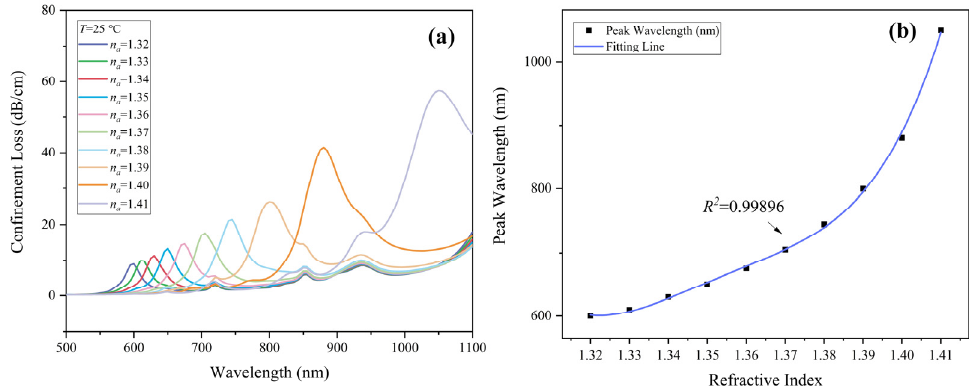
Figure 4. ( a ) CL spectrum of y- polarization core mode with various n a from 1.32–1.41 at T = 25 °C. ( b ) Resonance wavelength and its polynomial fitting line with various n a from 1.32–1.41 at T = 25 °C. Resolution describes the minimum indices change that a sensor can resolve. The res- olution of RI is defined as [26]: